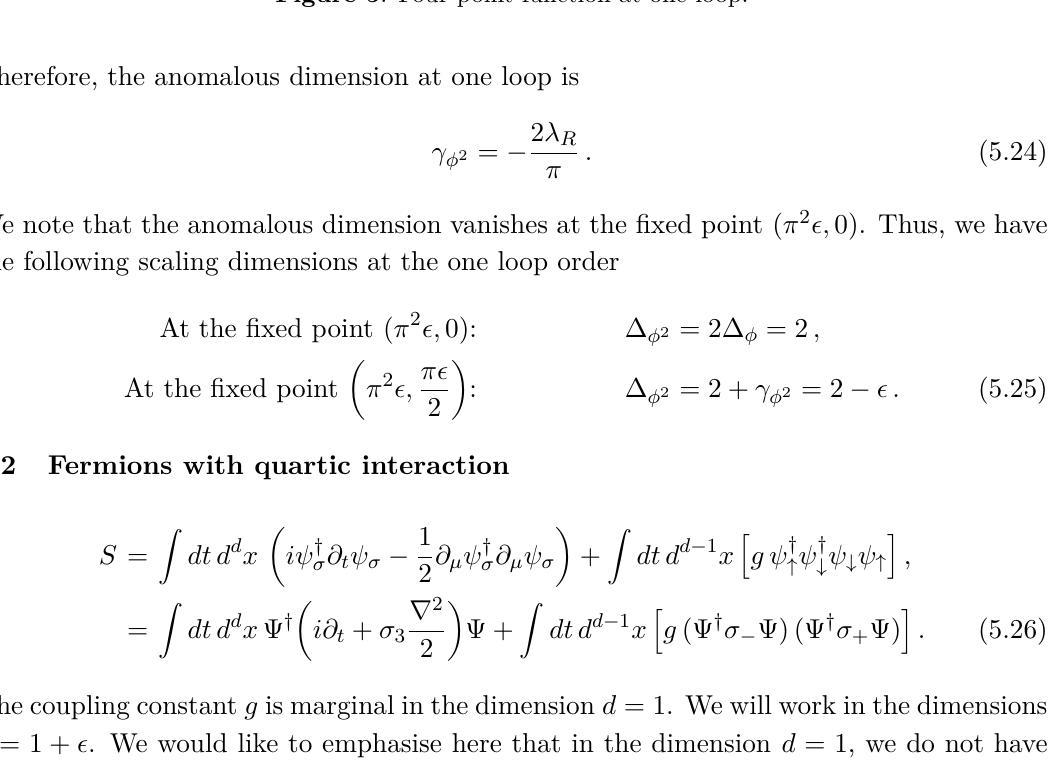
Figure 5 . Four point function at one